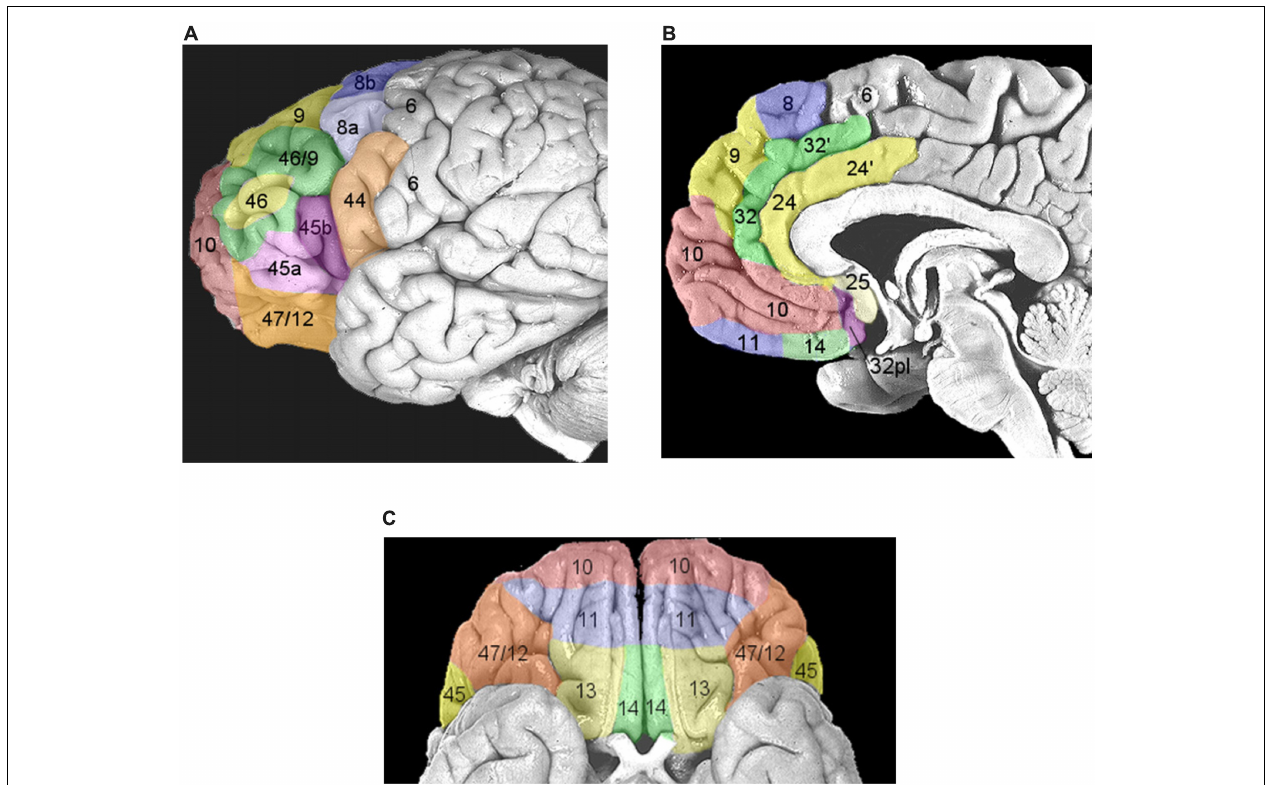
and BA25 (dorsocaudal portions are indicated with a hyphen). BA10 corresponds to the frontopolar cortex. The orbitofrontal cortex (OFC) corresponds to BA11 and BA14. (C) Areas of ventral orbital surface of the PFC. BA10 corresponds to the frontopolar cortex. Area BA47/12 corresponds to the pars orbitalis of the IFG. The OFC corresponds to BA11, BA13, and BA14. Reproduced with permission from Ridderinkhof etal.